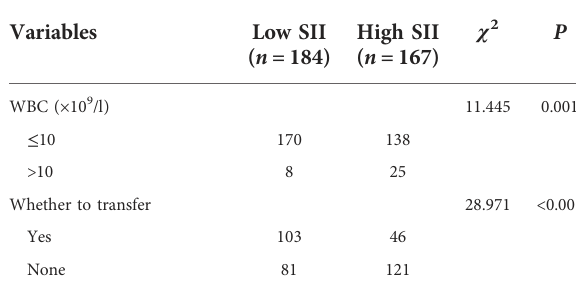
TABLE 1 Relationship between SII and clinicopathological factors in patients with hepatic alveolar